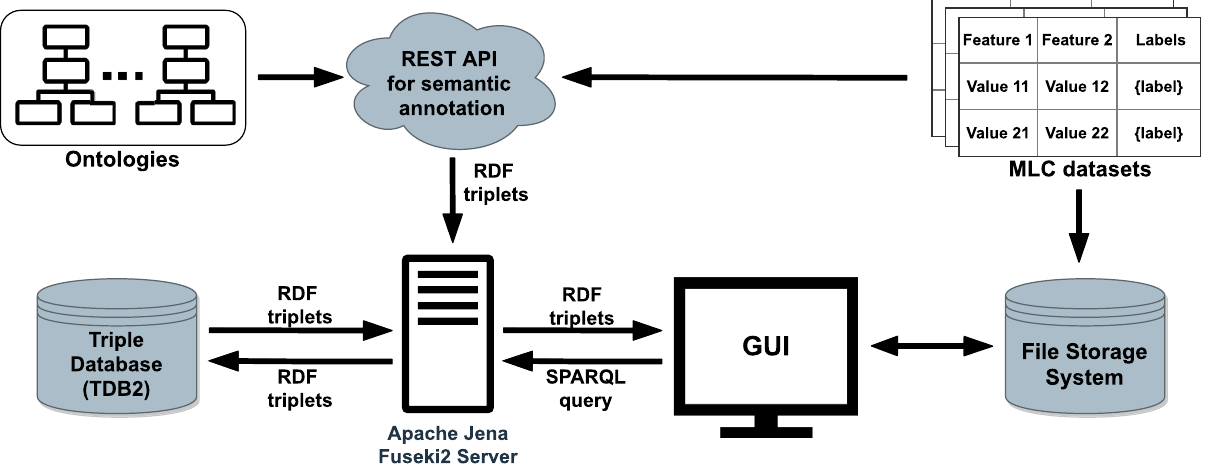
Figure 6. Client-server architecture of the web-based system behind the MLC dataset catalogue. The system comprises of several components, i.e., REST API for semantic annotation of datasets; a triple database, Apache Jena TDB2, for storage of the annotations in RDF format; an FTP file server to store the raw datasets in ARFF format; an Apache Jena Fuseki2 server that handles the semantic query requests; and a GUI that supports intuitive and interactive exploration of the datasets and the accompanying knowledge